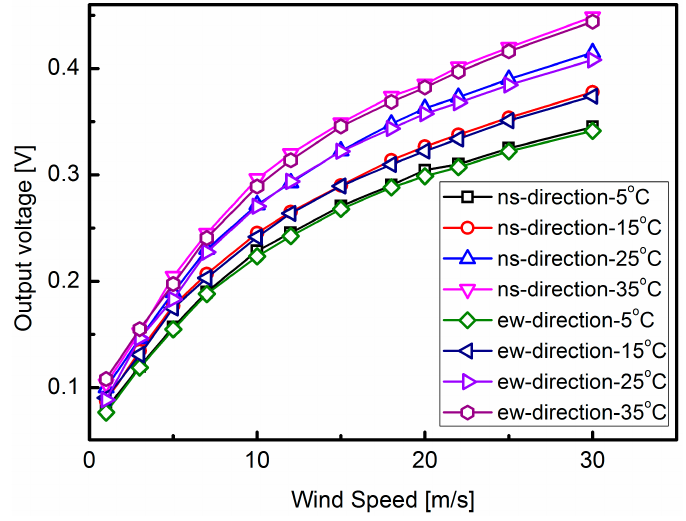
Figure 9. The output voltages in north-south and east-west directions at different ambient temperatures ranging from 5 °C to 35 °C.